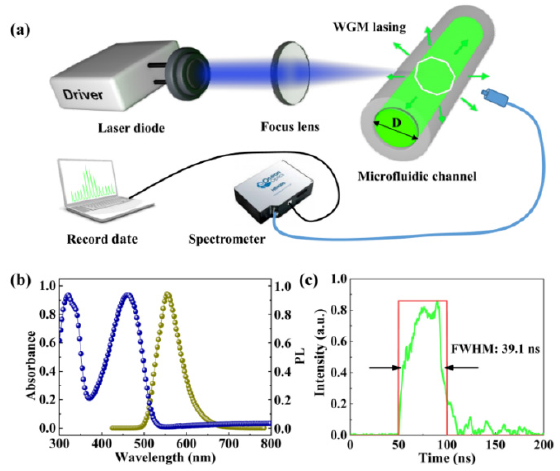
Figure 1. ( a ) Absorption (blue line) and photoluminescence (brown line) spectra of F8BT, with its absorption peak around 450 nm. ( b ) The schematic diagram of laser diode pumped polymer WGM lasers. ( c ) The actual full width at half maxima (FWHM) of the diode emission pulse is only 39.1 ns when the driving pulse is 50 ns.